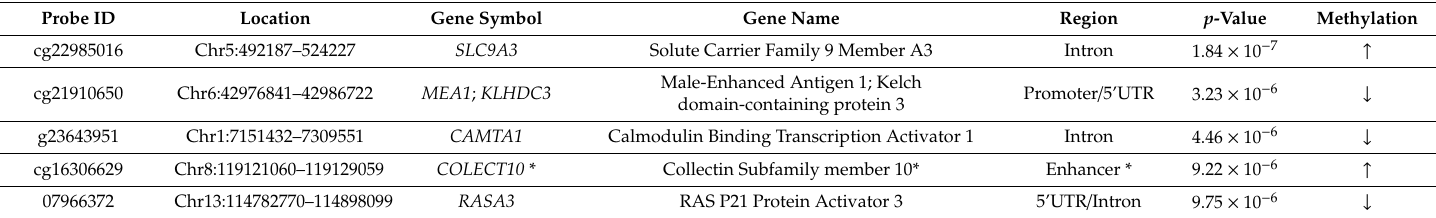
Table 2. The top five significantly di ff erentially methylated CpG sites between GDM and non-GDM groups.